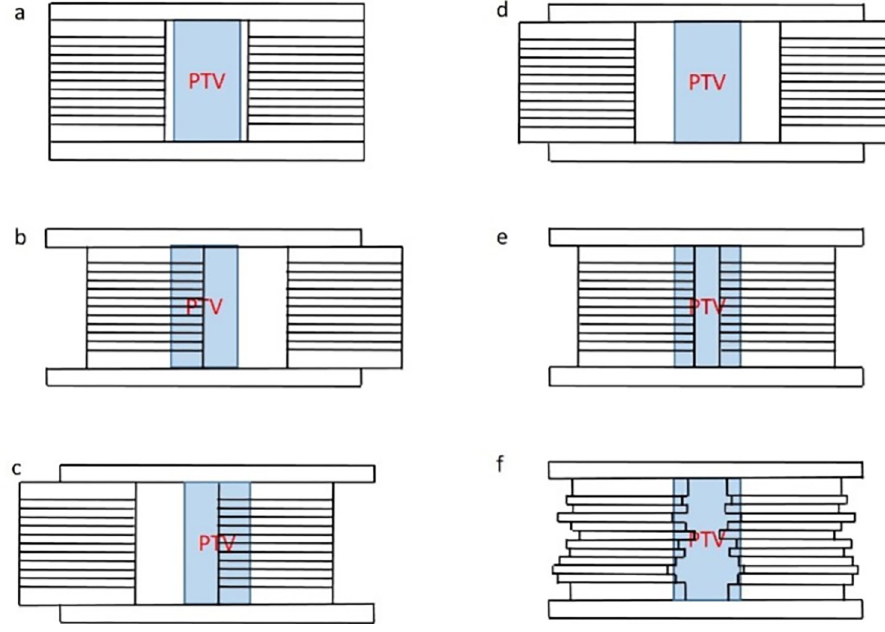
Fig 1. MLC position errors are introduced to each SBRT plan. (a) baseline plan; (b)(c) Type1, shift error; (d)Type2, opening error; (e)Type3, closing error; (f)Type4, random